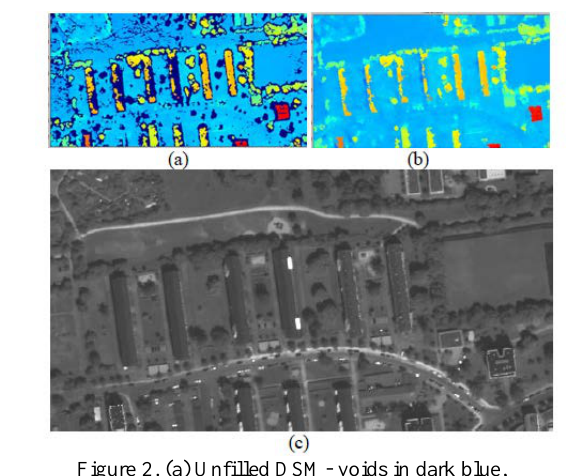
Figure 2. (a) Unfilled DSM- voids in dark blue, (b) initial coarse filled DSM, (c) orthophoto generated by the coarse filled DSM 2.1.2